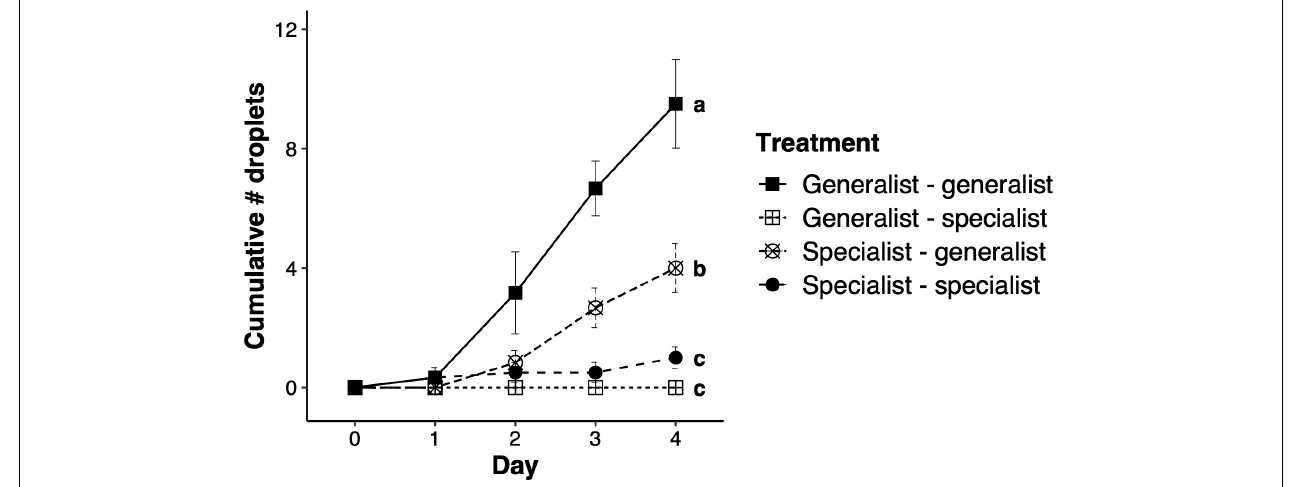
FIGURE 3 | Suppression of sticky droplets on honeysuckle after specialist spider mite feeding. Total number of droplets (mean ± SEM) produced after spider mite herbivory by honeysuckle over four consecutive days. Treatments in the legend are based on the combination of mite herbivory on honeysuckle leaves 2 days before day 0 (by genotype left of the dash) and after day 0 (by genotype right of the dash). Letters next to data points at day four represent significant differences between